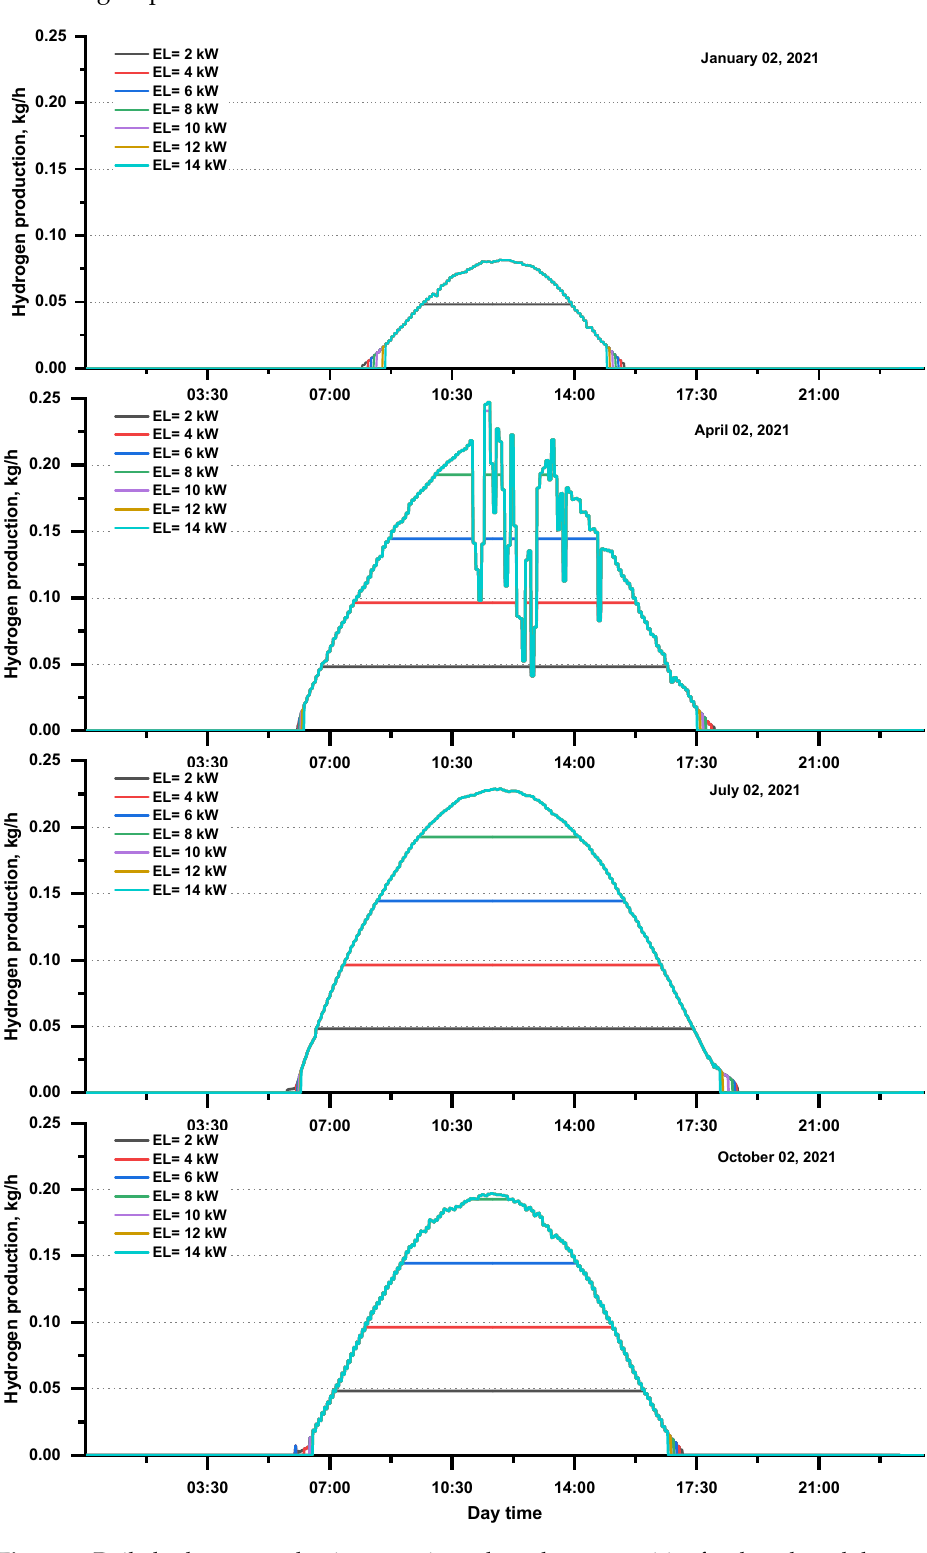
Figure 6. Daily hydrogen production at various electrolyzer capacities for the selected days.